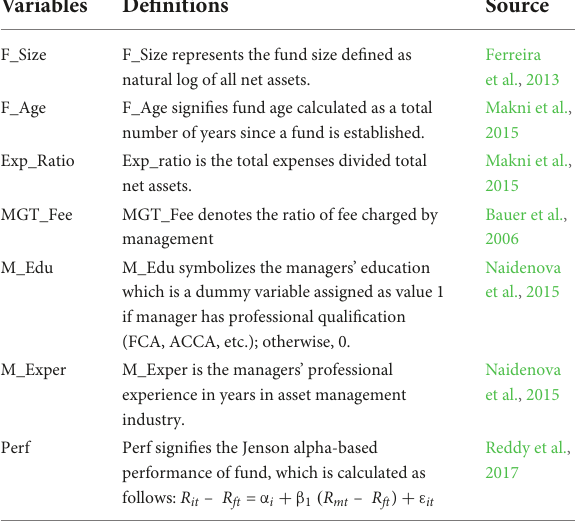
TABLE 1 Detail of control variables’